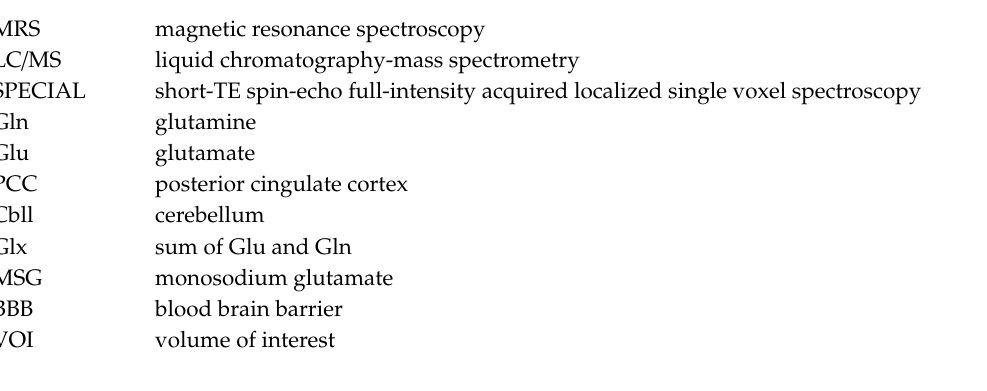
Figure S1: Concentrations of Glutamine and Glutamate in Plasma and Brain; Figure S2: tCr Concentrations in PCC and Cbll of Two Measurements; Table S1: Cram é r–Rao Lower Bound (CRLB) in PCC and